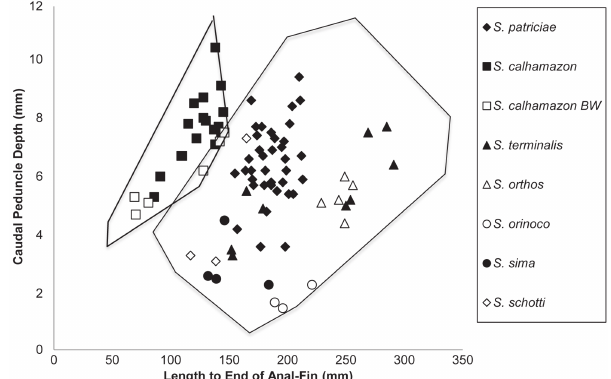
Fig. 10. Biplot of length to end of anal-fin (LEA) vs . caudal peduncle depth (CPD) for eight species of Sternarchella showing the separation between S. calhamazon from white water, S. calhamazon from black water (BW), and seven other Sternarchella species in CPD.